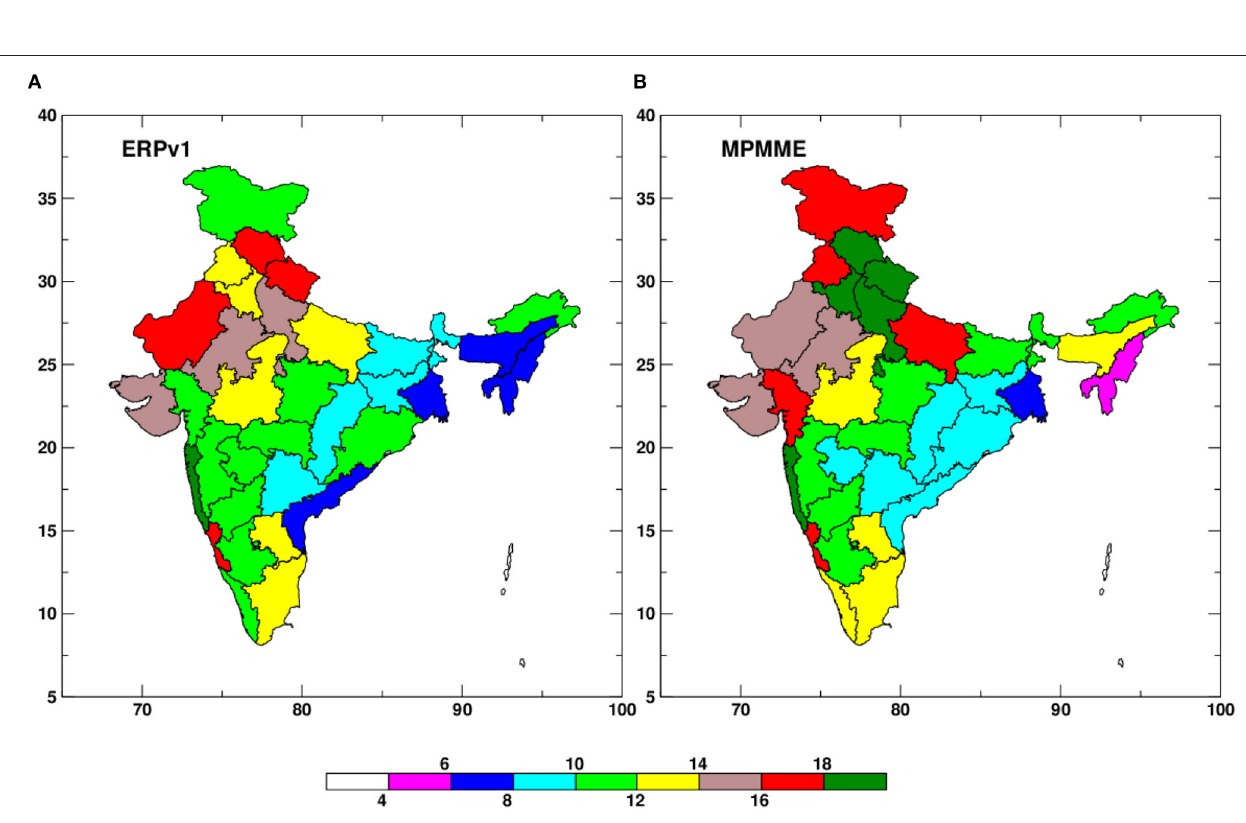
Frontiers in Climate |